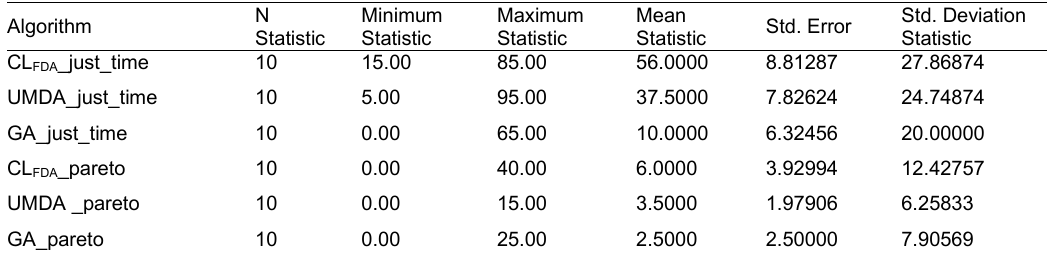
Table 5. Descriptive analysis, variable %Optimum for j30_17 dataset